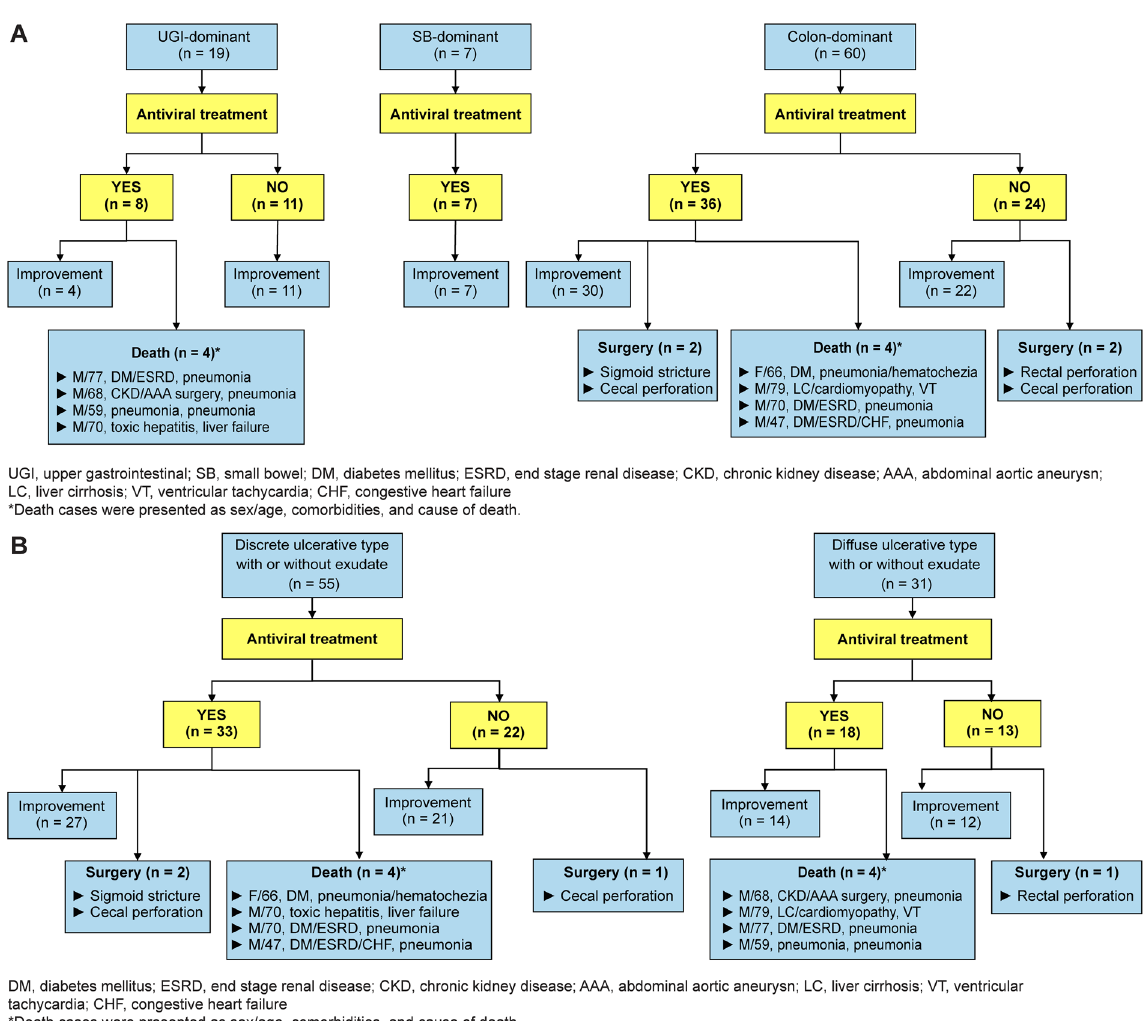
Figure 4. Clinical course of cytomegalovirus gastroenterocolitis in immunocompetent patients according to ( A ) location of involvement. ( B ) endoscopic type. UGI, upper gastrointestinal; SB, small bowel; DM, diabetes mellitus; ESRD, end-stage renal disease; CKD, chronic kidney disease; AAA, abdominal aortic aneurysm; LC, liver cirrhosis; VT, ventricular tachycardia; CHF, congestive heart failure. *Death cases are presented as sex/age, comorbidities, and cause of